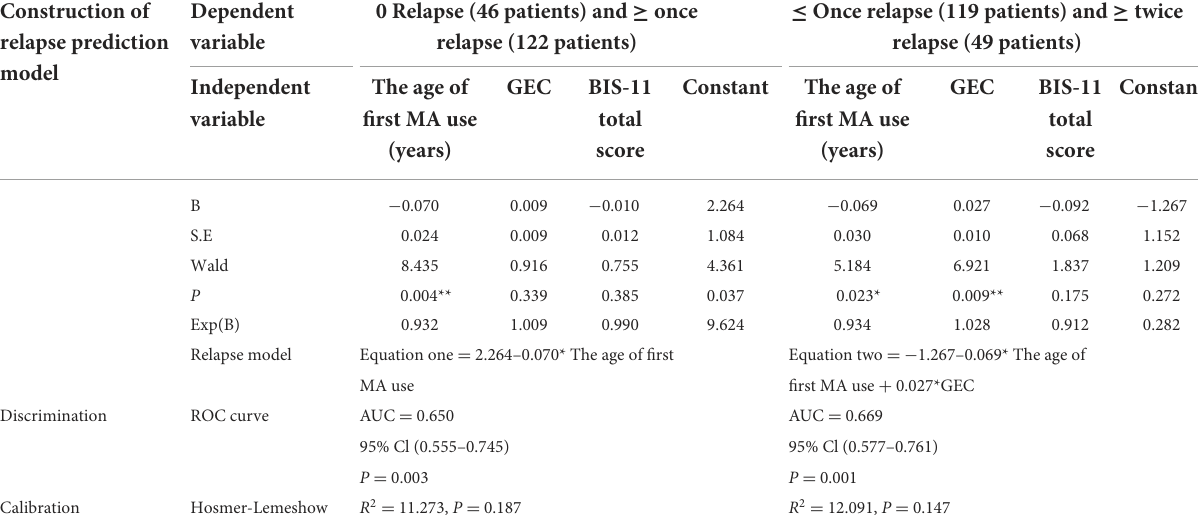
TABLE 6 Construction of prediction model for MA relapse using binary logistic regression